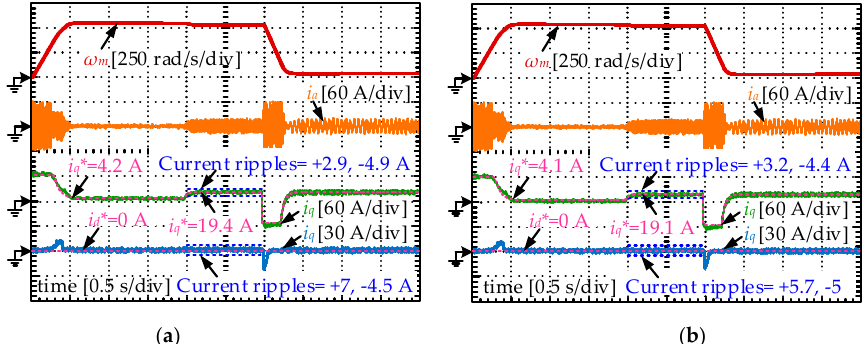
Figure 12. Experimental results of the traditional FCS-MPCC method under different resistance and inductance disturbances: ( a ) L 0 = 2 L , ∆ L = − L , R s0 = R s , ∆ R s = 0; ( b ) L 0 = L , ∆ L = 0, R s0 = 5 R s , ∆ R s = − 4 R s .